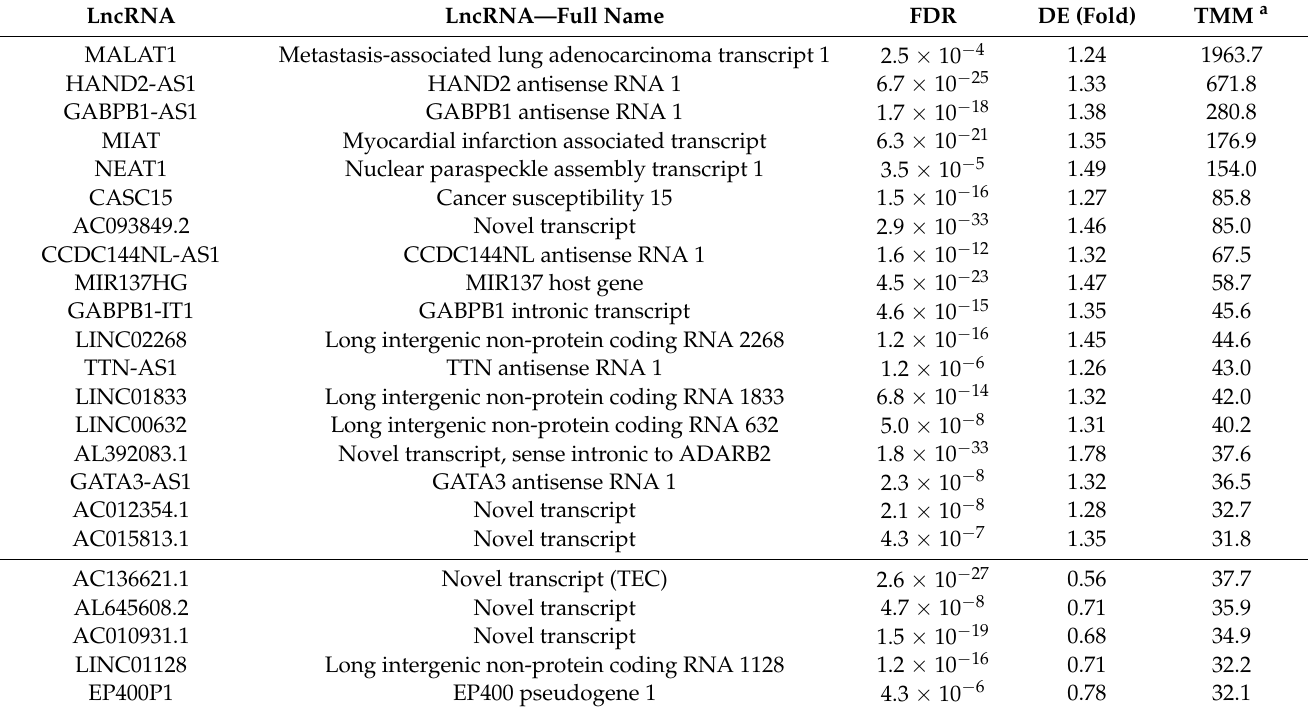
Table 1. Differentially expressed lncRNA genes in cells exposed to Sin1 (24 h).